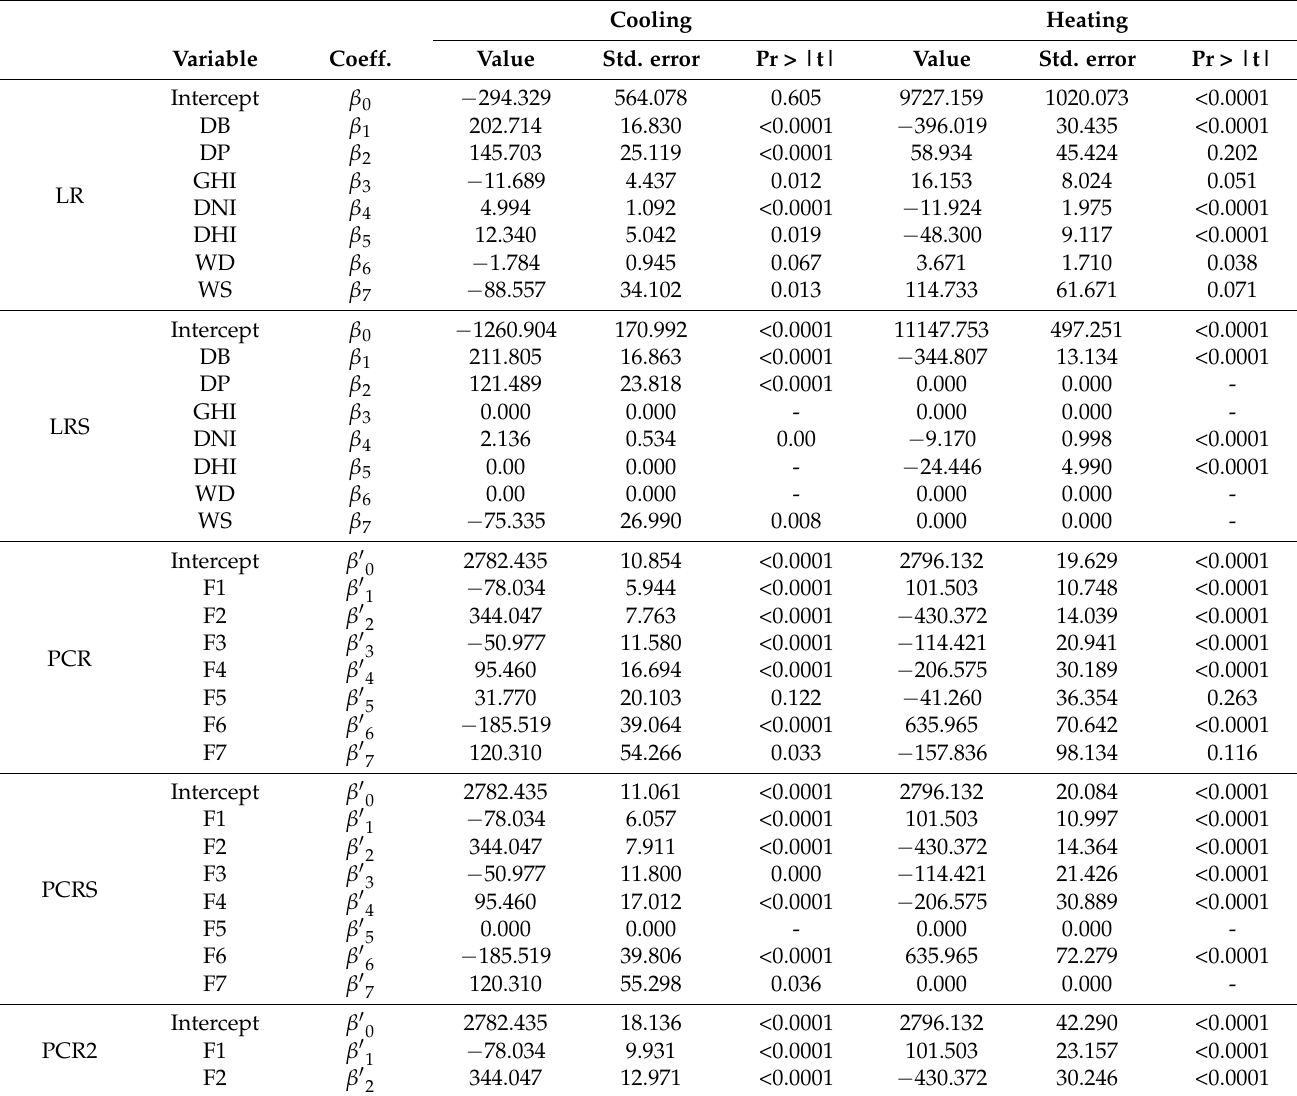
Table A5. Details of the regression models coefficients and standard